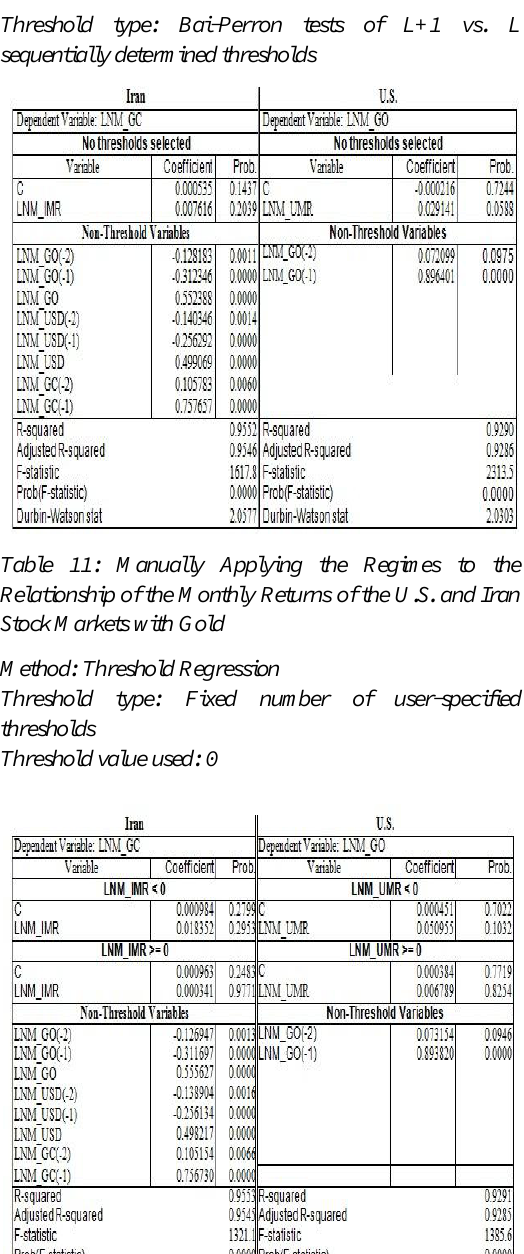
Table 10: Investigating the Existence of Different Regimes in the Relationship between the Monthly Returns of the U.S. and Iran Stock Markets and Gold